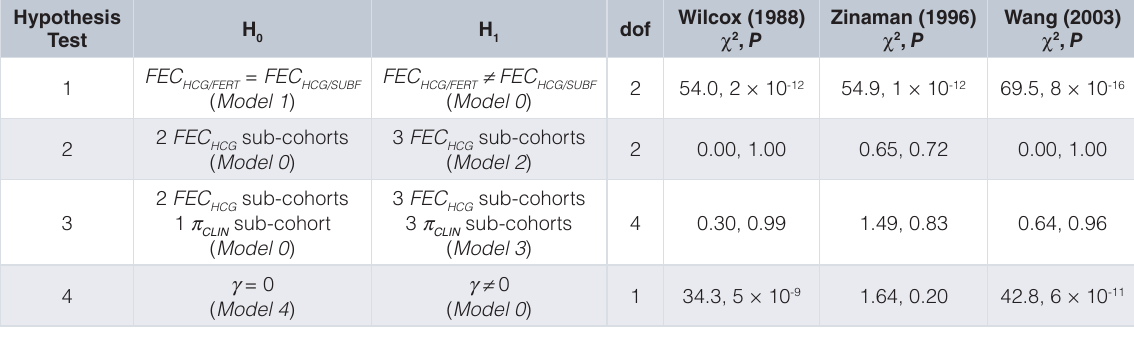
Table 2. Statistical results of hypothesis tests comparing the models shown in Table 1 ( Model 0 ) with alternative models. Degrees of freedom (dof) is the difference in the number of estimated parameters between the models. χ 2 is the difference in objective function values ( ELS ) for the two models. P values were calculated using likelihood ratio tests. The models are defined in brackets. H